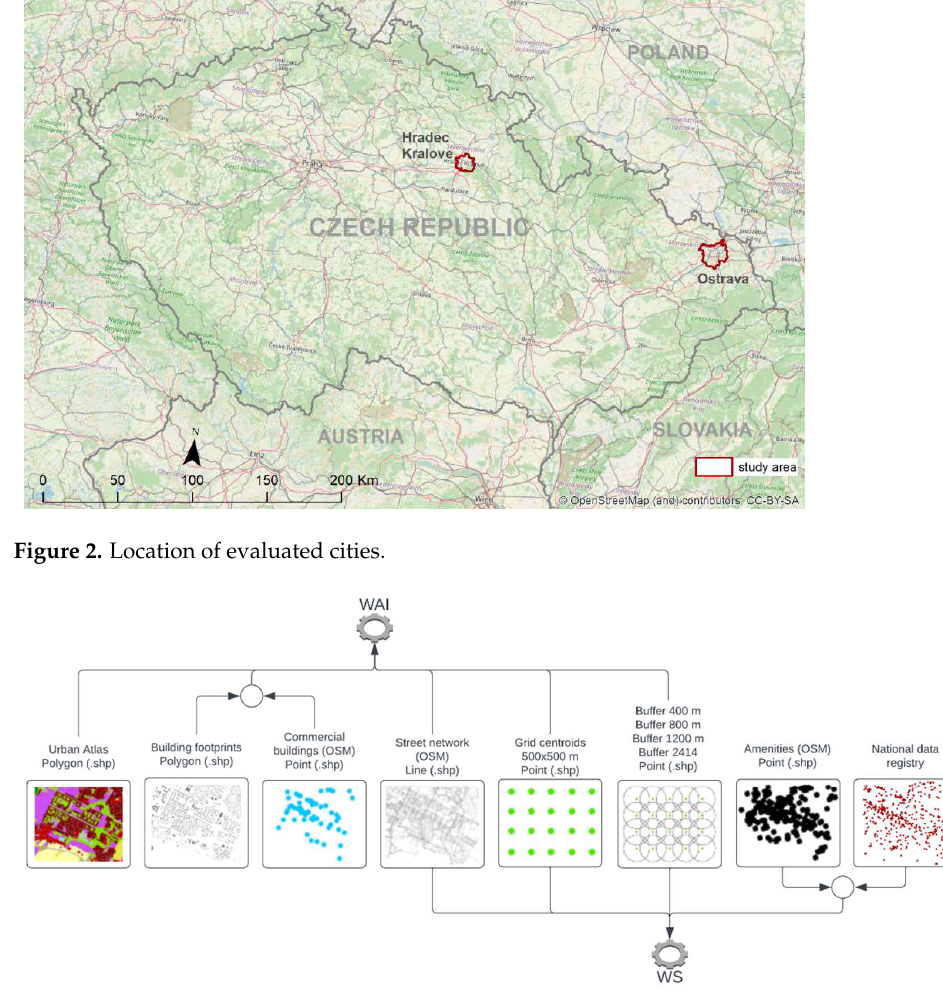
Figure 3. Main input data required for calculation of WAI and WS.